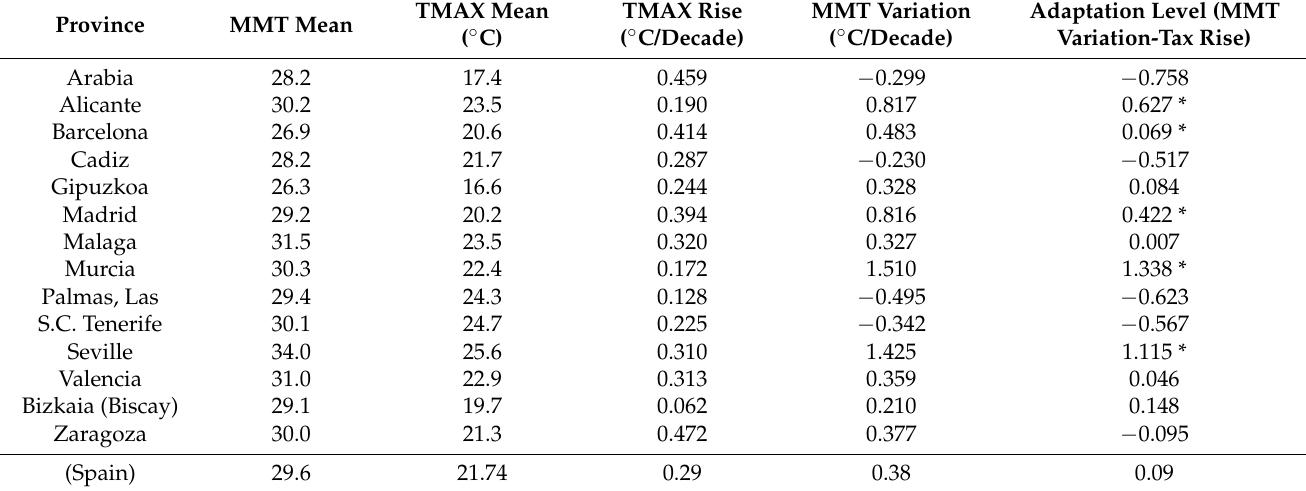
Table 1. Relationship of variables, by urban province, between minimum mortality temperature (MMT) in persons aged 65 years or over, showing MMT mean, TMAX mean, trend by decade in TMAX, variations in MMT, and adaptation levels. * p <